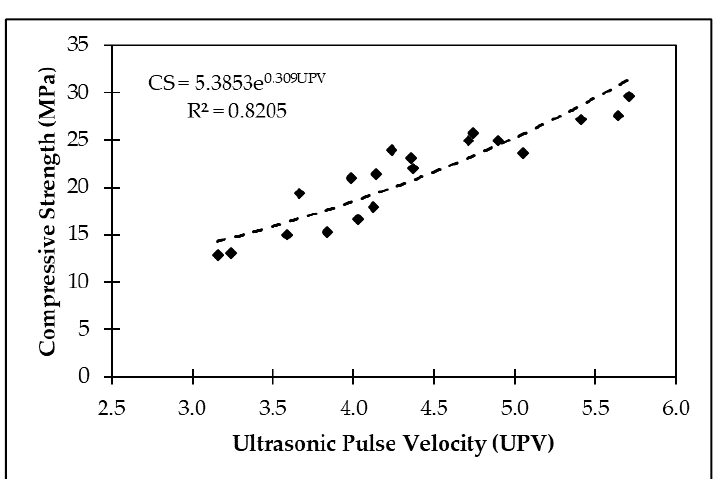
Figure 12. Regression equations for compressive strength corresponding to